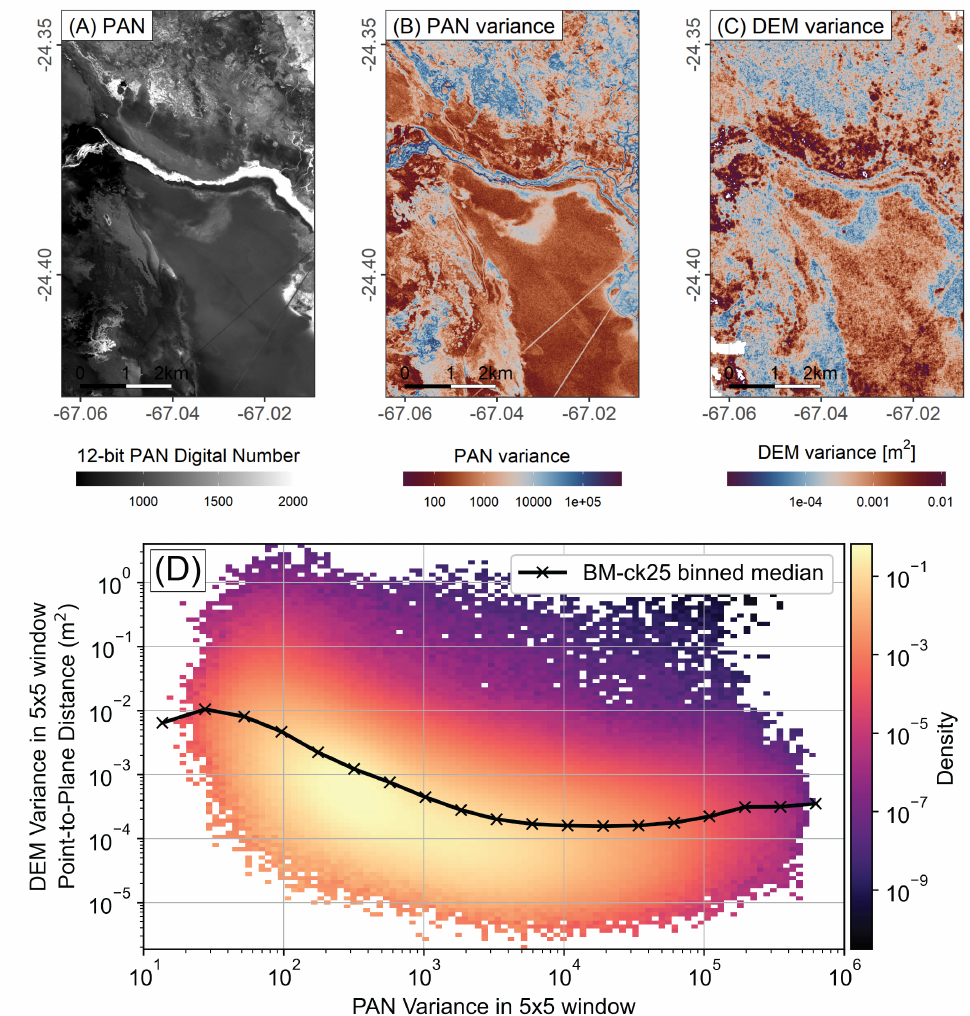
Figure 6. ( A ) 2000 × 3000 pixel (6000 × 9000 m) clip of the SPOT6 PAN B-scene from the central salar (cf. Figure 2A). Grayscale variations (image texture) caused by salt and wind-blown dust; ( B ) variance calculated in a 5 × 5 pixel window from the original PAN scene; ( C ) DEM variance for the SPOT6 BM-ck25 3 m DEM, also calculated in a 5 × 5 pixel window using plane-fitting and the variance of point-to-plane distances. Note the reversed color scales in ( B ) (low to high, red to blue) compared to ( C ) (low to high, blue to red), in order to highlight the fact that lower PAN variance values (red colors in ( B )) correspond to higher DEM variance values (red colors in ( C )), and vice versa; ( D ) the variables shown in map view in ( B , C ) plotted graphically using a 2D histogram to highlight density of the ∼ 6 × 10 6 underlying pixels (not plotted), as well as median bins calculated from all